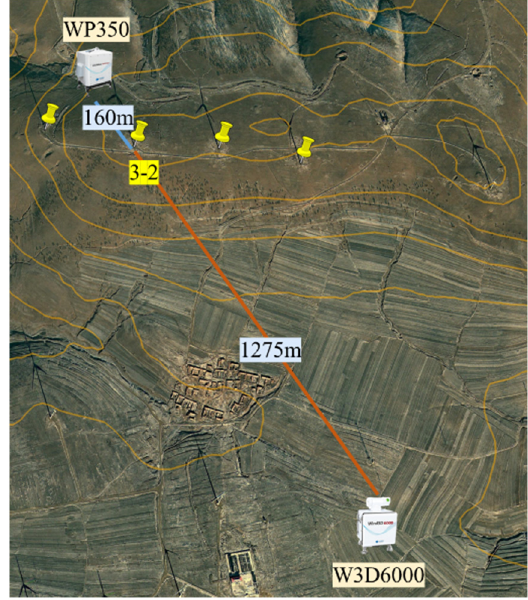
Figure 5. Layout of lidars.